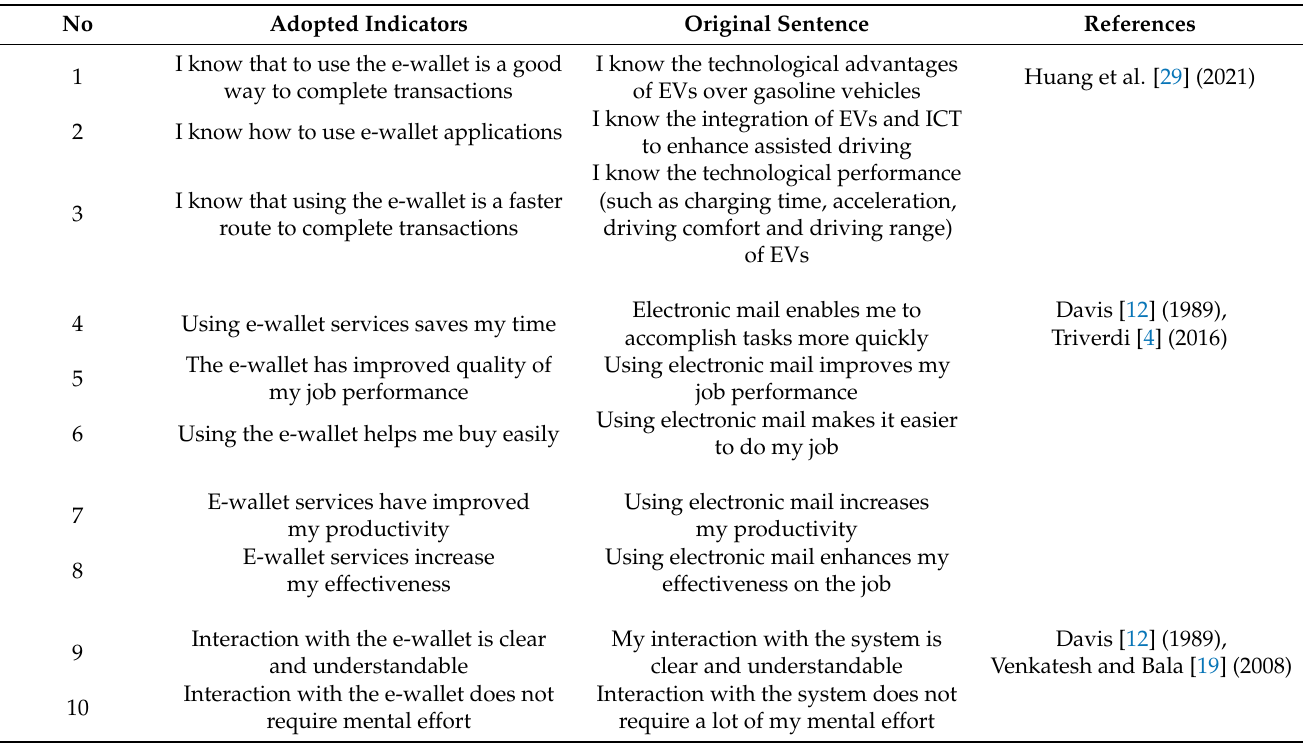
Table 1. Adopted indicators and original sentences used in conceptual